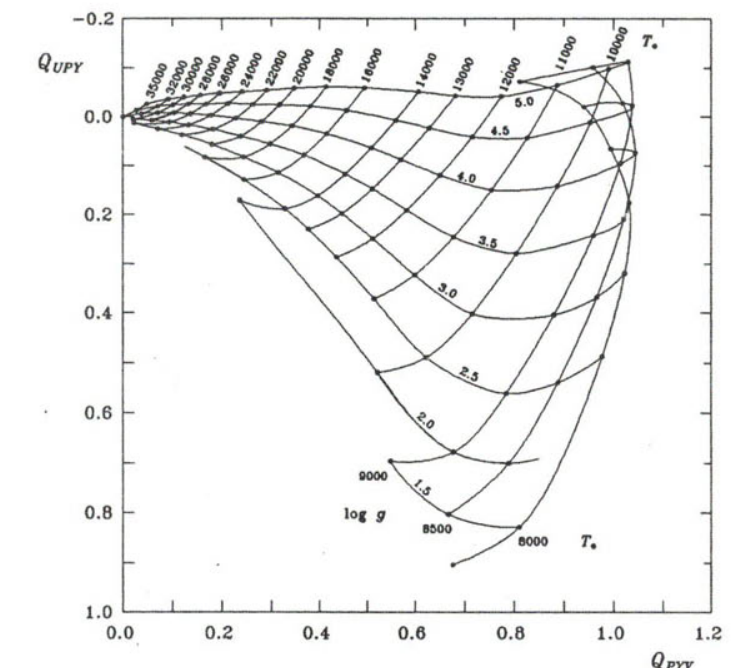
Fig. 1. The QuPYtQpYV diagram calibrated in effective tempera- tures and surface